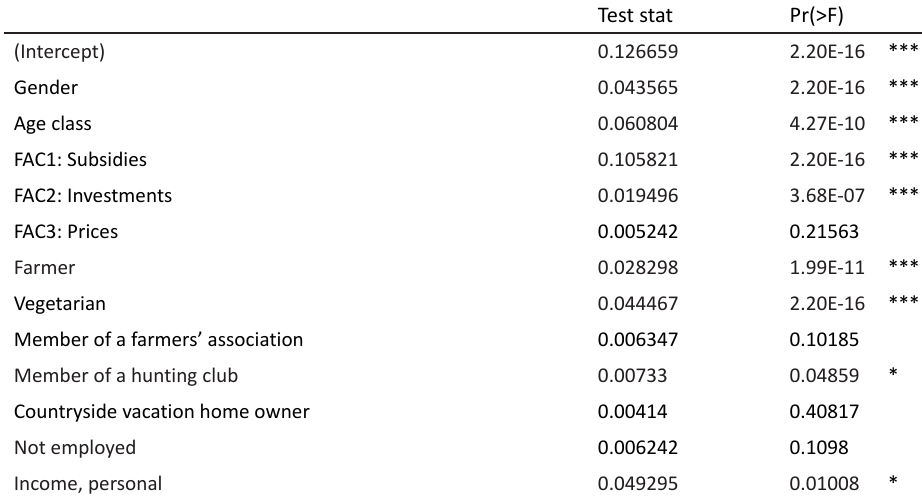
Clusters based on budget allocation